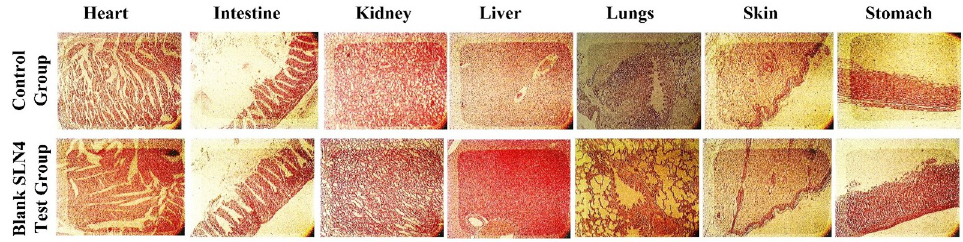
Fig 10. Histopathological analysis of Heart, intestine, kidney, liver, lungs, skin and stomach of control group animals and blank SLN4 test group animals.